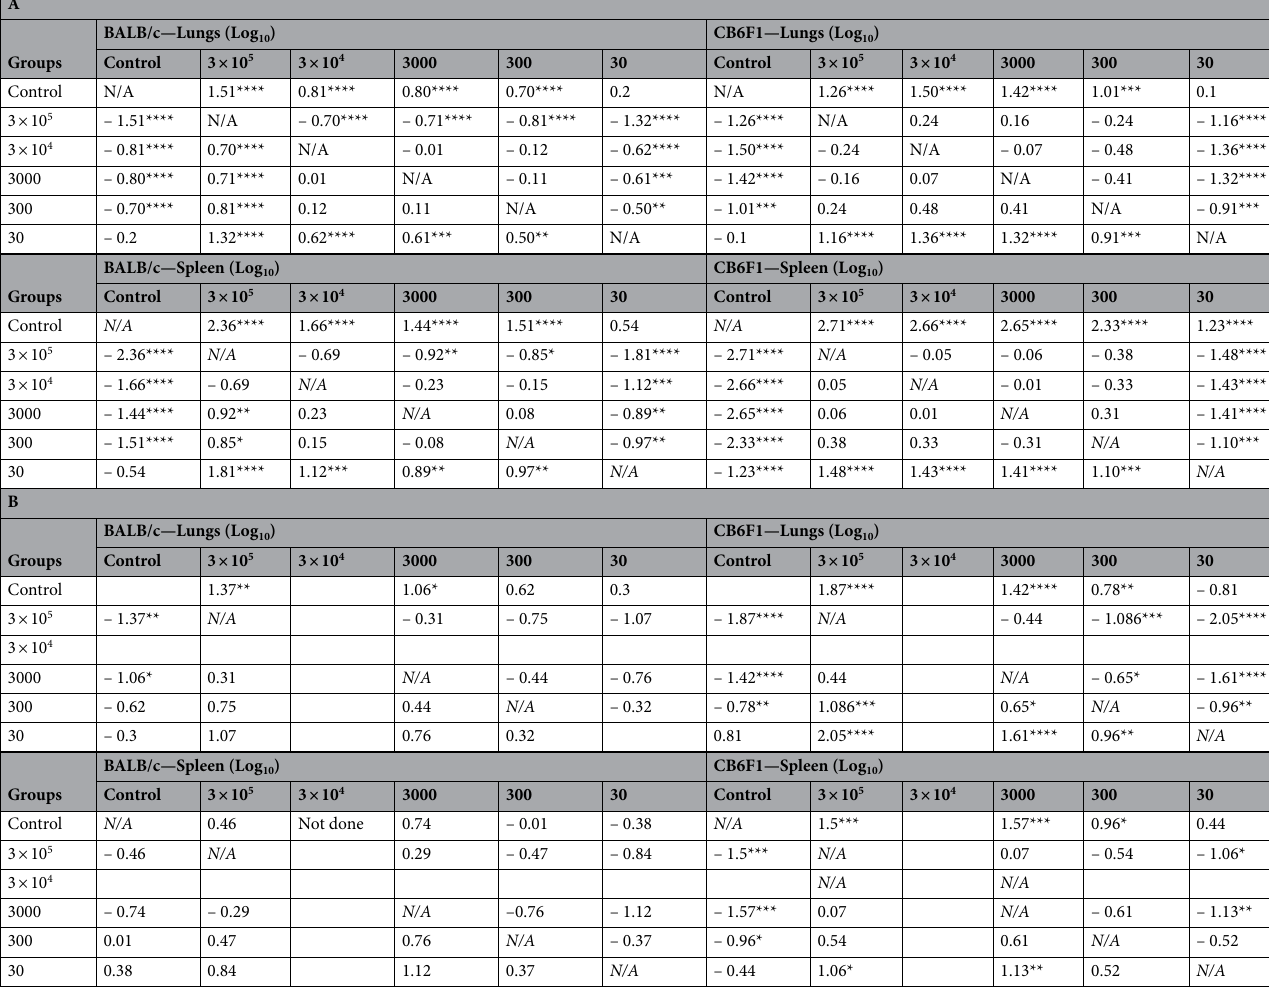
Table 1. Lung and spleen protection data for BALB/c and CB6F1 mice when infected with H37Rv or HN878 strains. The values in the Log 10 protection data is the difference in the means of control group when compared to the BCG dose groups and the difference within BCG groups. Data is representative of two independent experiments for H37Rv and one experiment for HN878. Values representing difference for the mean Log 10 of the BCG and control groups (left column)—mean Log 10 of the BCG groups (Top Row). A, Difference between the means of the lungs and spleen of Log 10 values for BALB/c and CB6F1 mice infected with H37Rv. B, Difference between the means of the lungs and spleen of Log 10 values for BALB/c and CB6F1 mice infected with HN878. One-way ANOVA, Tukey’s multiple comparison test was performed for BALB/c and CB6F1 mice infected with H37Rv or HN878. *ρ < 0.05, **ρ < 0.005, ***ρ < 0.0005, ****ρ <